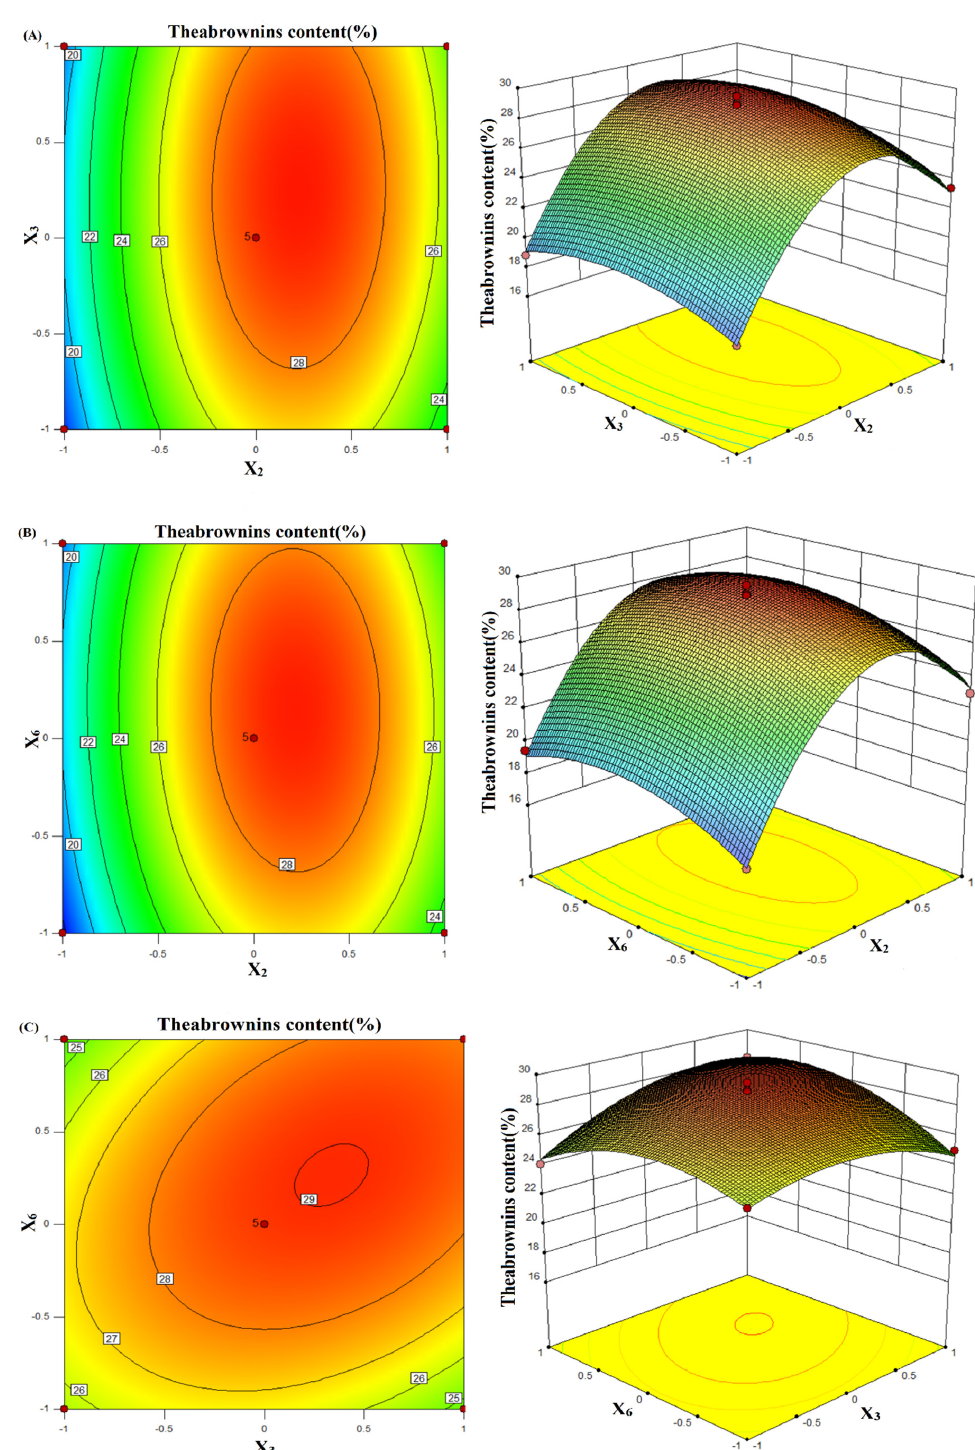
Figure 1. Contour line and response surface of the effect of the interaction between the feed-liquid ratio (X 2 ) and bacterial concentration (X 3 ) on the theabrownins content ( A ). Contour lines and response surface of the effect of the interaction of feed–liquid ratio (X 2 ) and rotation speed (X 6 ) on the theabrownins content ( B ). Contour lines and response surface of the effect of the interaction of bacterial concentration (X 3 ) and rotation speed (X 6 ) on the theabrownins content ( C ). Table 6. Box–Behnken test variance analysis.